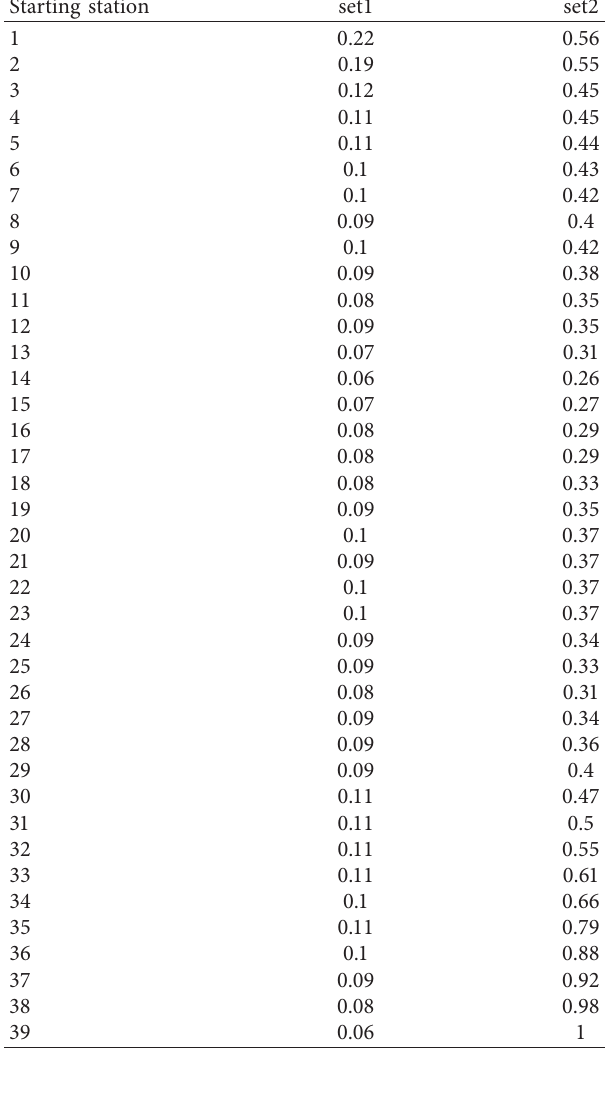
Table 7: Passenger ratio data.